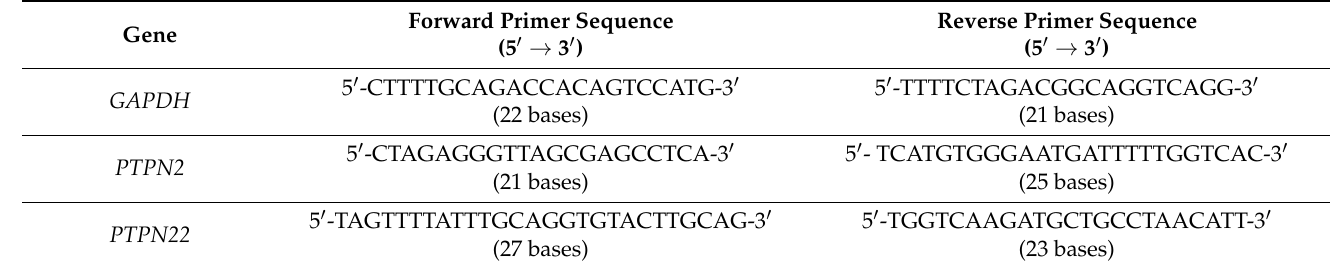
Table 3. RT-qPCR primer sequences for tested